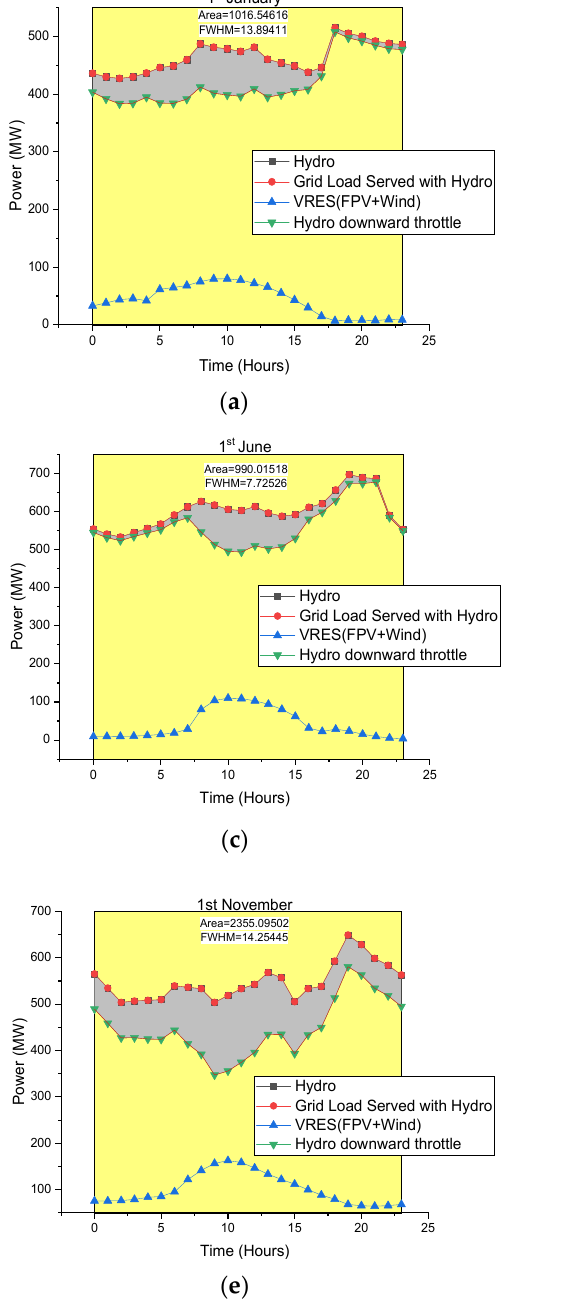
Figure 19. ( a ) Optimal daily dispatch of hydro, FPV and wind on 1 January to serve a fraction of the grid demand. ( b ) Optimal daily dispatch on 1 March. ( c ) Optimal daily dispatch on 1 June. ( d ) Dispatch on 1 September. ( e ) Dispatch on 1 November.